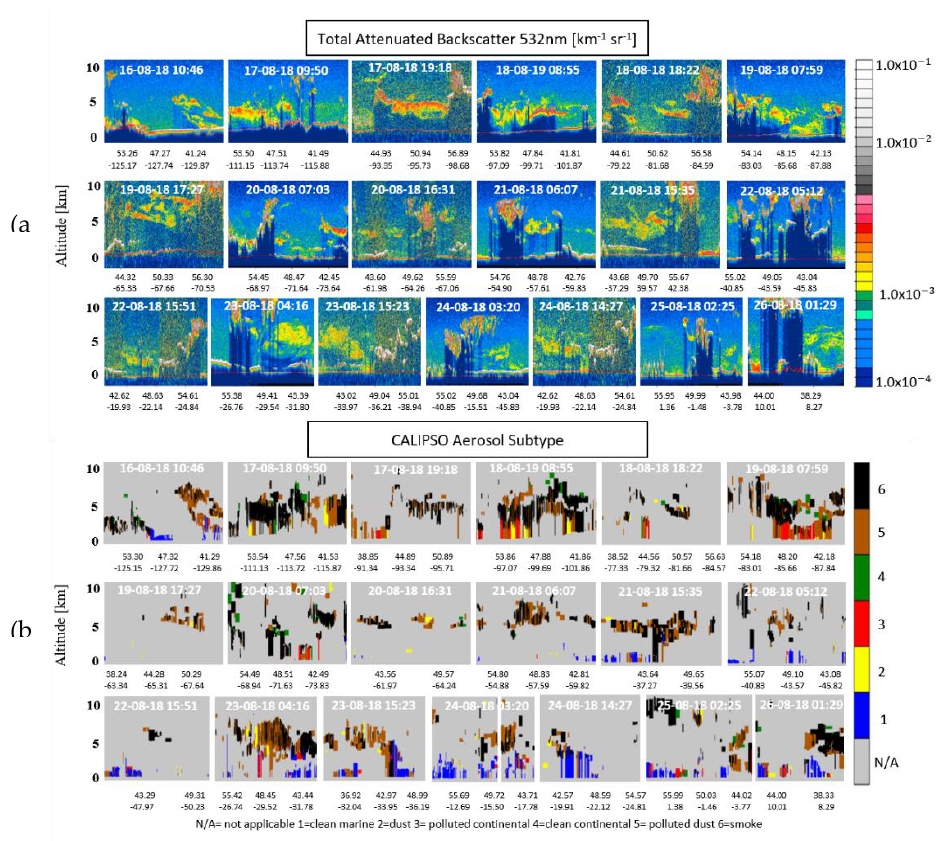
Figure 4. ( a ) CALIPSO total attenuated backscatter coefficient at 532 nm and ( b ) aerosol subtypes versus altitude, latitude and longitude for nighttime and daytime orbits (16–26 August 2018).